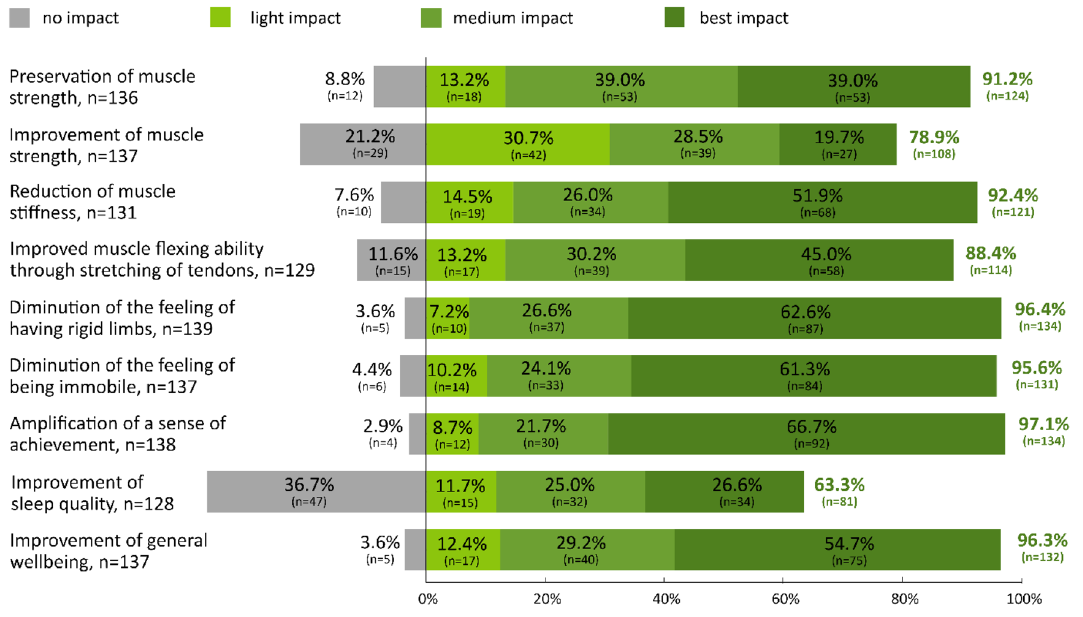
Figure 4. Domain-oriented participant experiences of the MME. Participant experiences of the MME as analyzed by domain were assessed on a 11-point Likert scale ranging from 0 (no impact) to 10 (best possible impact). The impacts were classified into four groups: no impact (0 points), light impact (1 to 3 points), medium impact (4 to 6 points), and most impact (7 to 10 points). MME, motor-assisted movement exerciser; n, number of